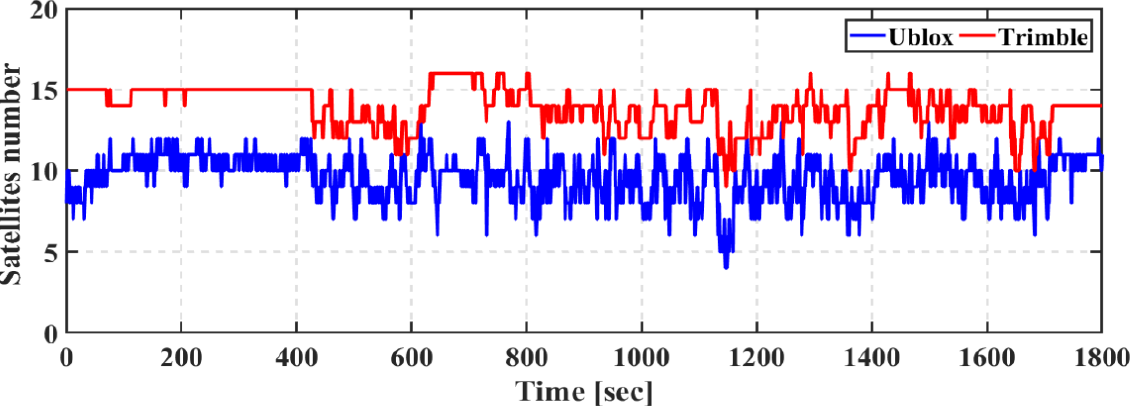
Figure 4. First field trial: Number of tracked GPS, GLONASS, and Galileo satellites.